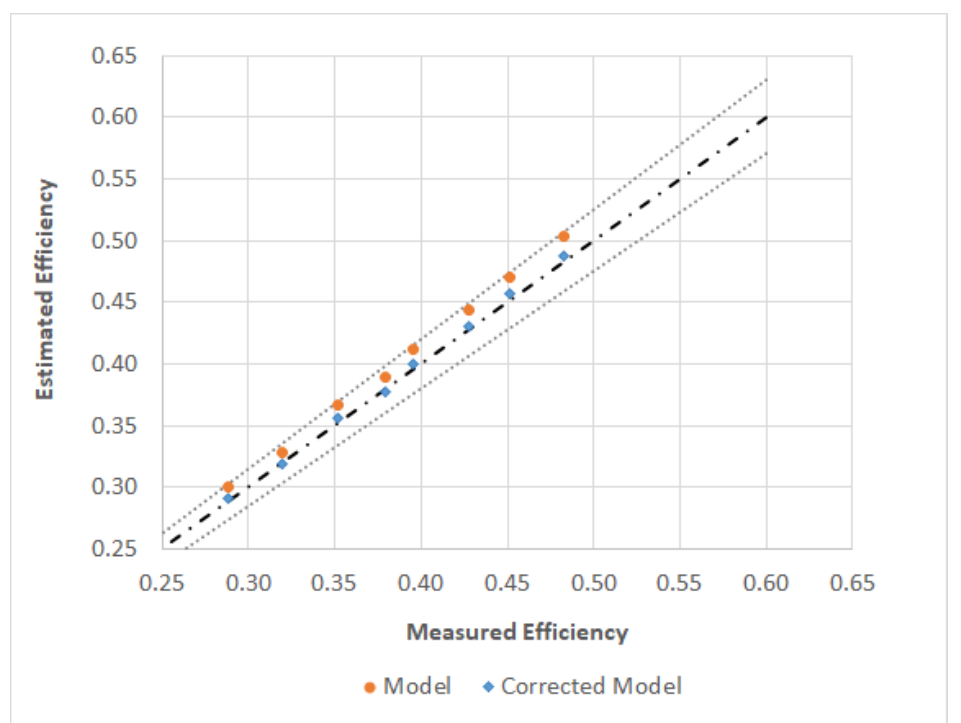
Figure 12. Validation and calibration of the model for HARDI ISO F-110-06 nozzles.